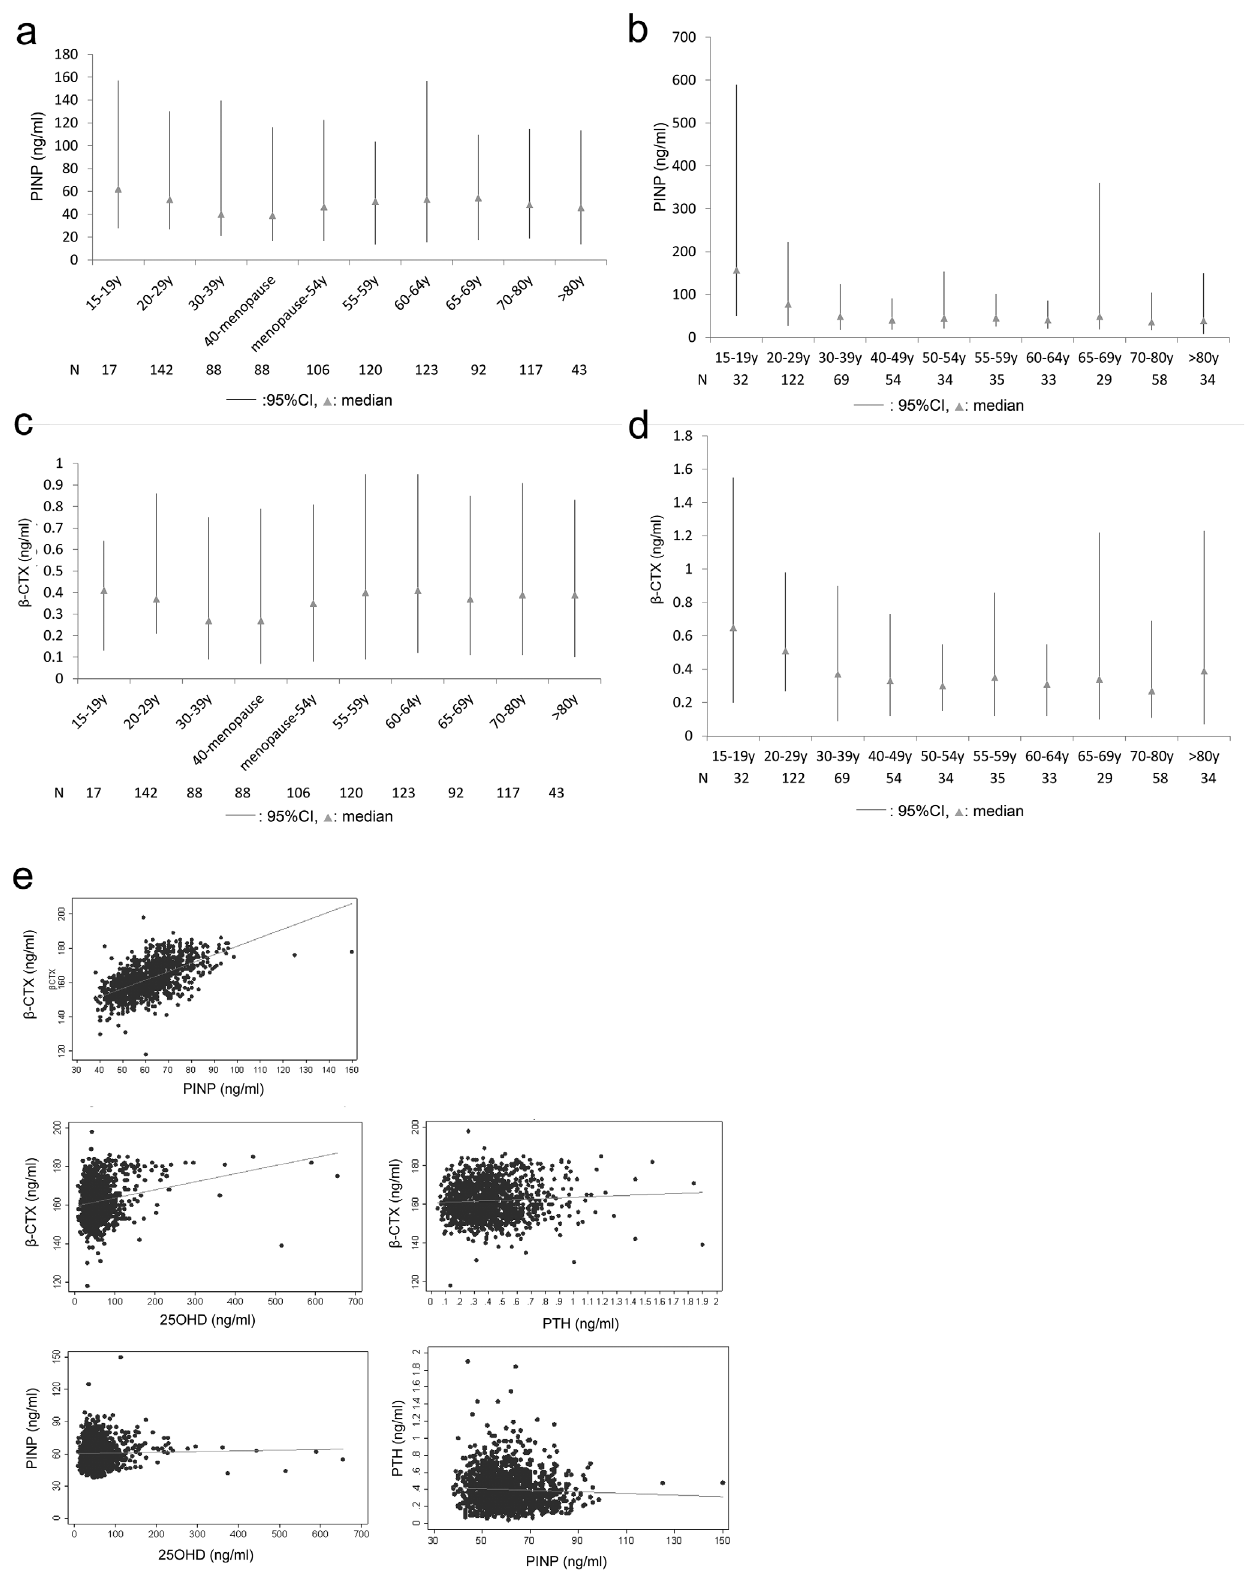
Figure 2. PINP and b -CTX levels in different groups and the results of correlation analysis. a PINP levels in female age groups. b PINP levels in male age groups. c b -CTX levels in female age groups. d b -CTX levels in male age groups. e The correlation between b -CTX, PINP, PTH and 25OHD levels in participants.